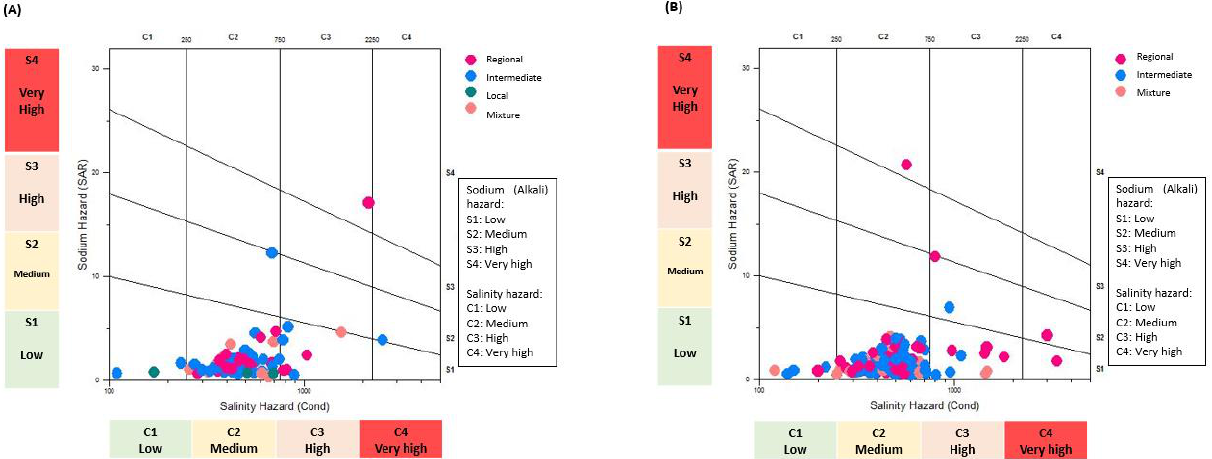
Figure 12. Classification of groundwater samples by means of the Wilcox diagram of the different flow systems: ( A ) 2005 and ( B ) 2015.